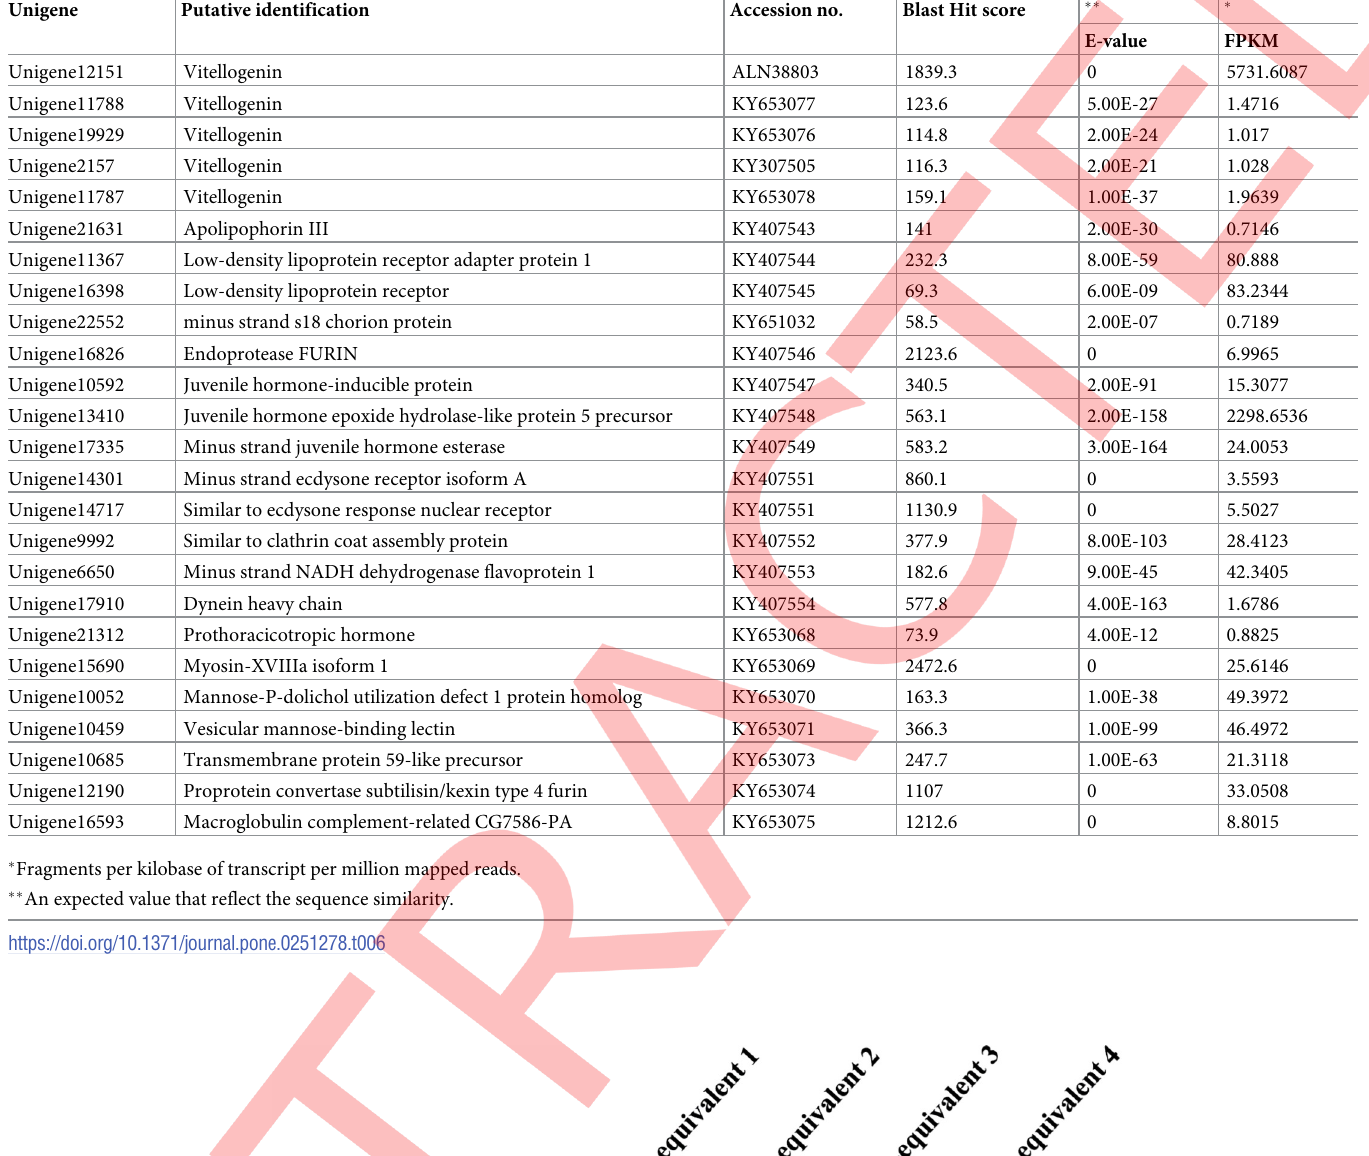
Table 6. Reproduction control genes identified from the fat body tissues transcriptome of Rhynchophorus ferrugineus . Unigene